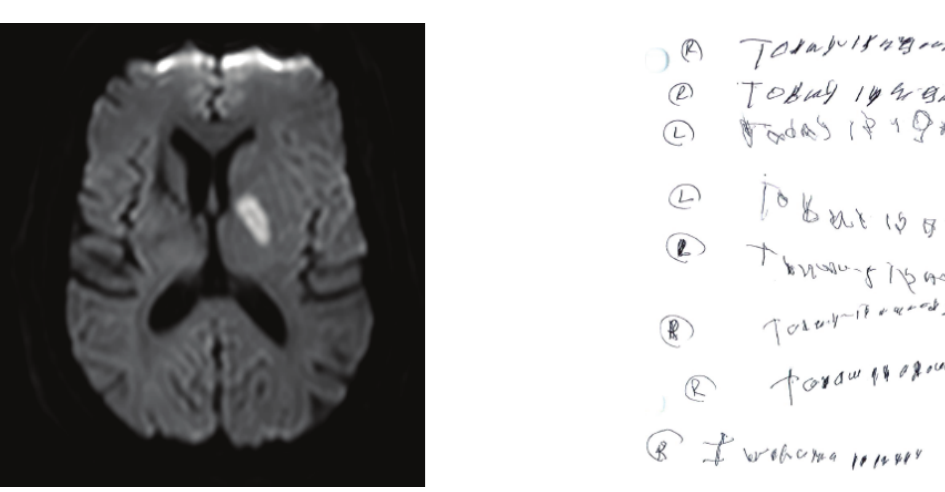
Figure 2: Handwriting samples. Micrographia was primarily demonstrated in the patient’s right hand (designated “R”) as com- pared to his left hand (designated